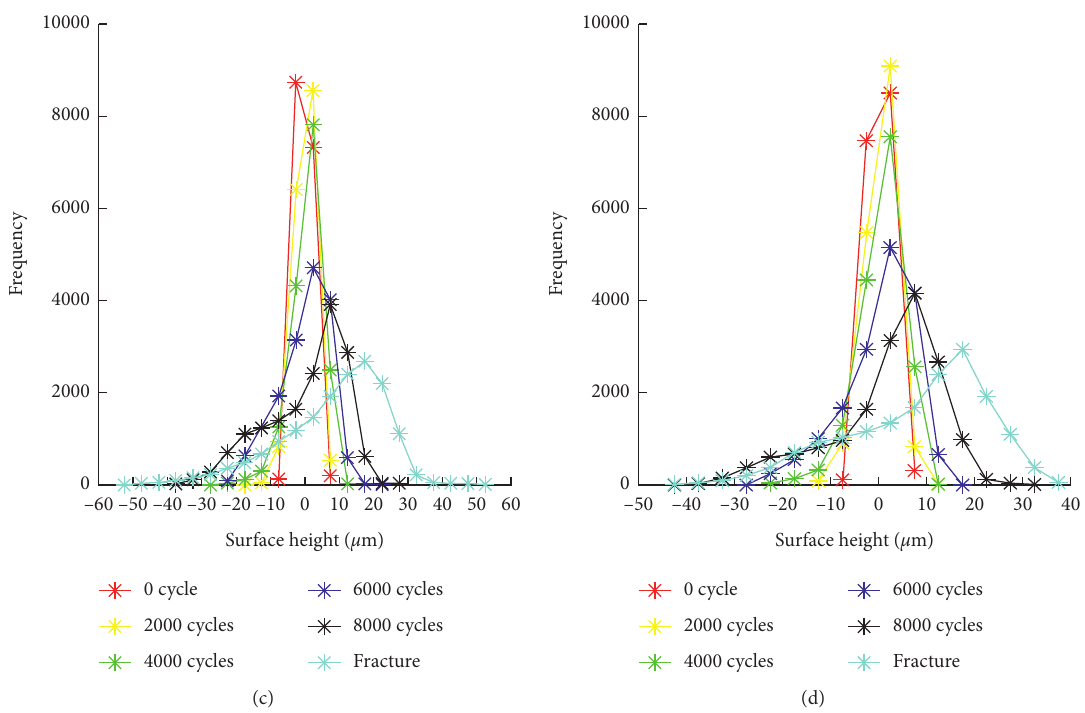
Figure 10: The surface height frequency distribution curve of the metal fatigue process. (a) Specimen no.1. (b) Specimen no. 2. (c) Specimen no. 3. (d) Specimen no.